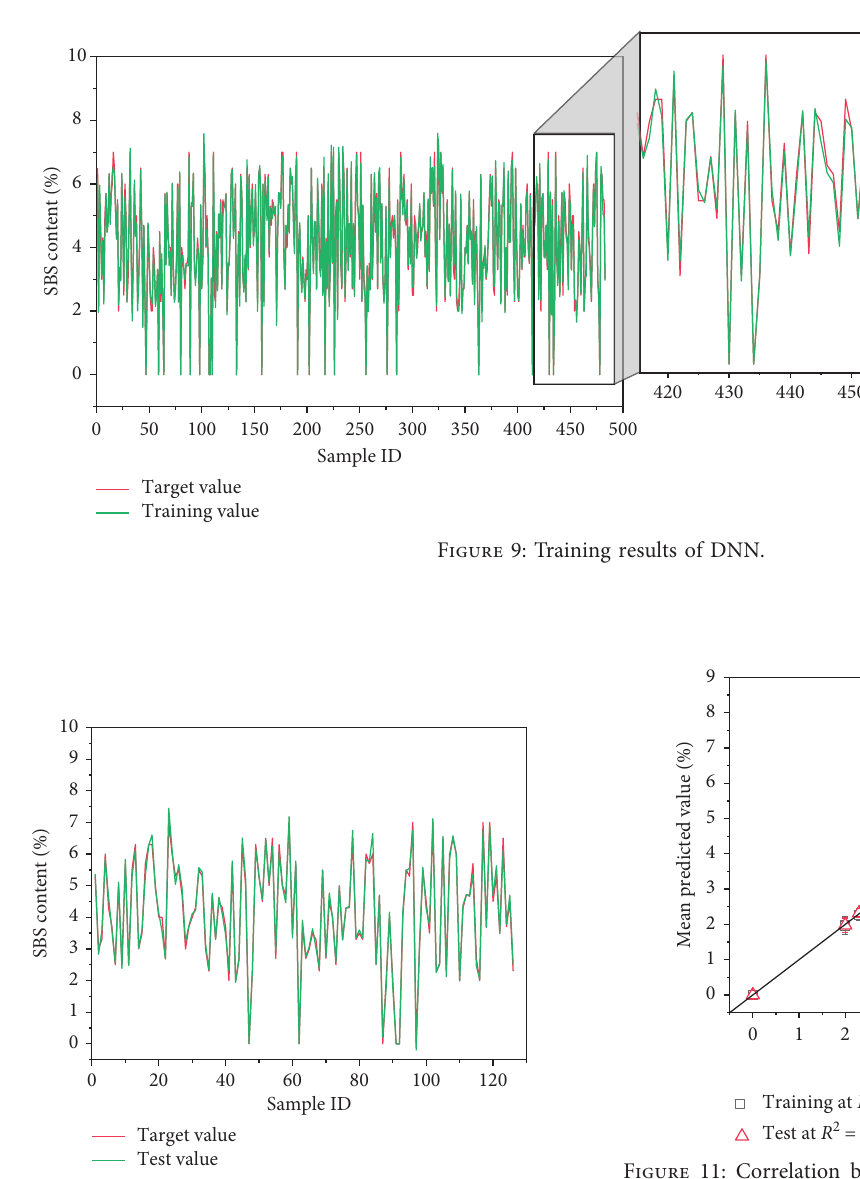
Figure 10: Testing results of DNN.